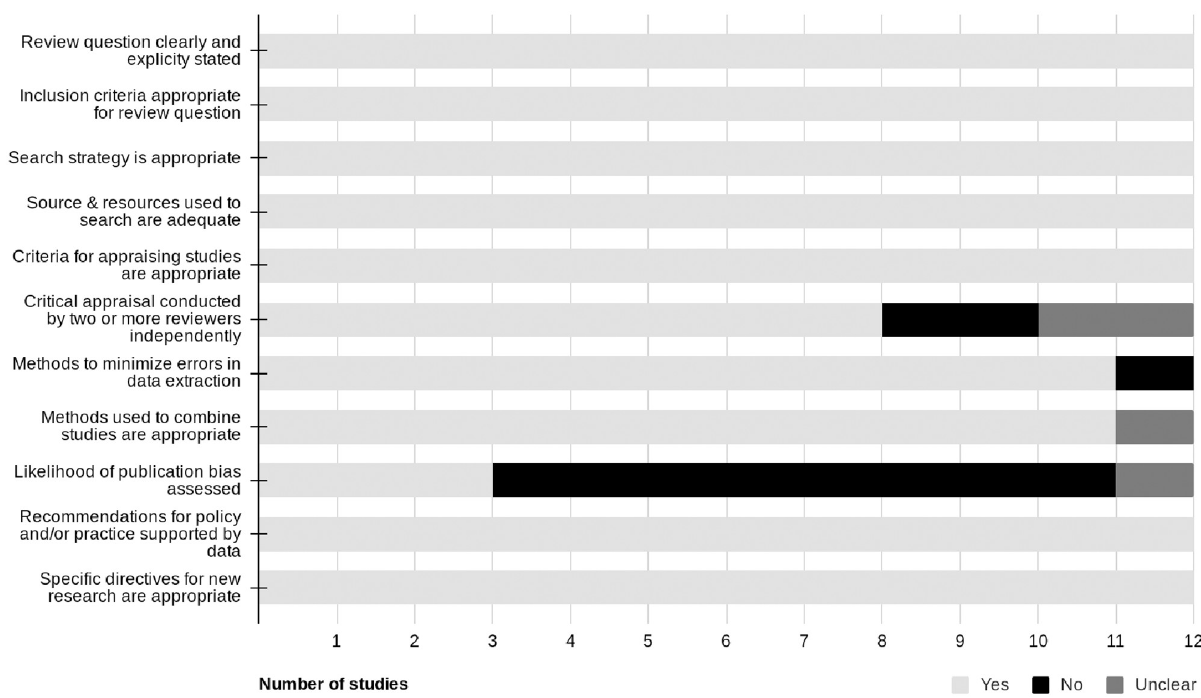
Fig 2. JBI Critical Appraisal Checklist for Systematic Reviews and Research Syntheses. Bar graph highlighting the quality components of included systematic reviews/meta-analyses for reporting methodological quality.